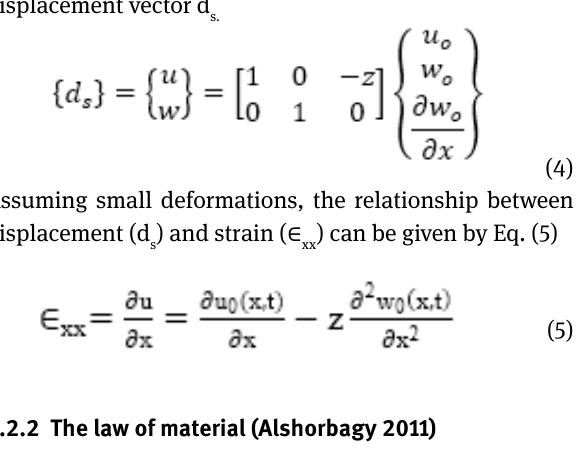
Figure 2: Beam element Transverse components